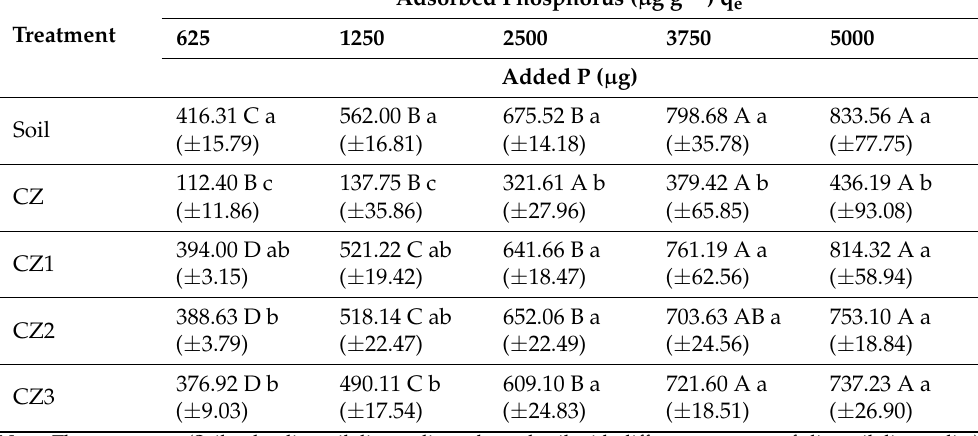
Table 9. Interactive effects of the different phosphorus concentrations and treatments (Soil only, clinoptilolite zeolite only, and soil with different amounts of clinoptilolite zeolite) on the amounts of phosphorus